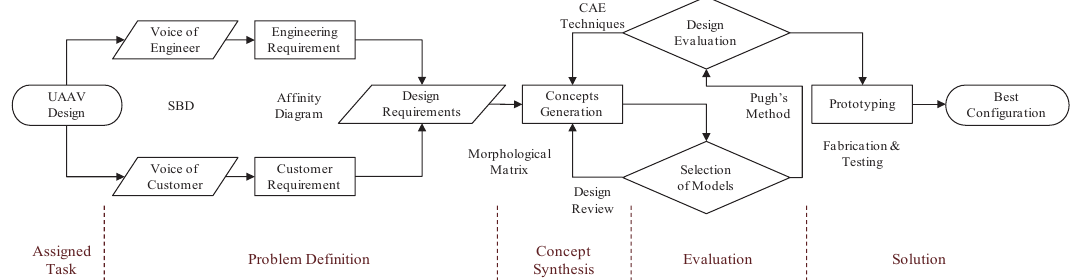
Figure 1. Design methodology of